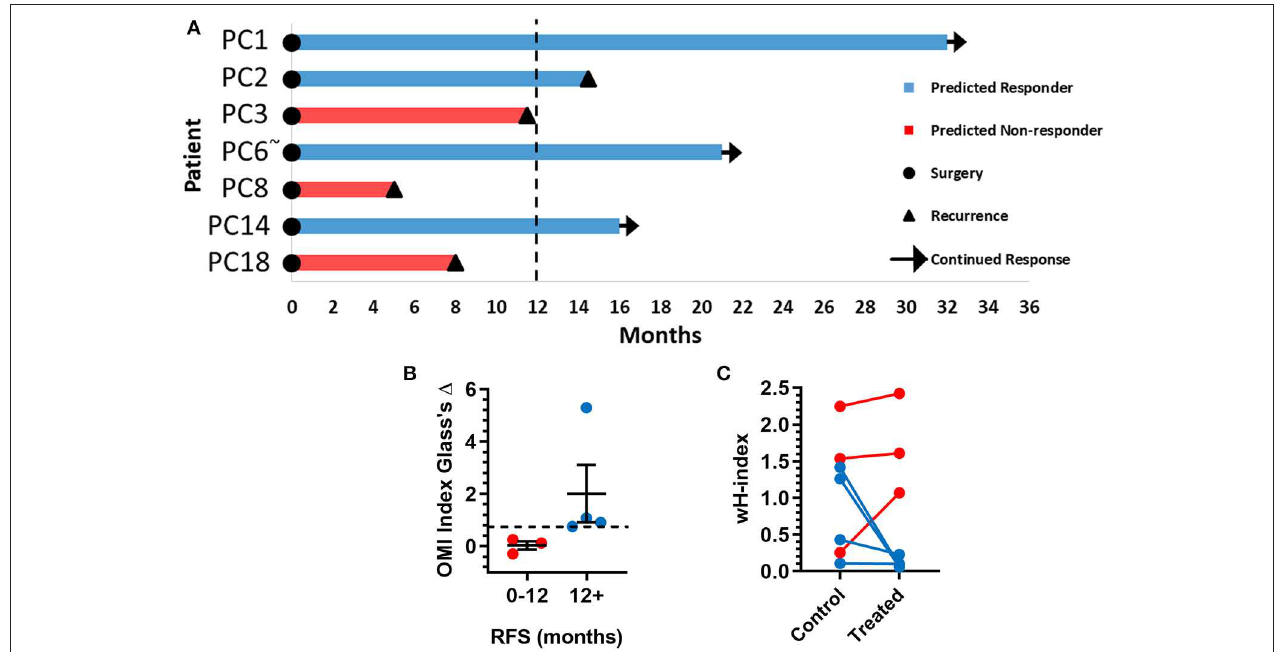
FIGURE 6 | Pancreatic cancer patient clinical outcomes while on adjuvant therapy. (A) Swimmer plot indicating the number of months without recurrence following surgical resection of the tumor and adjuvant treatment. Patients are classified as predicted responders and non-responders based on organoid response profiles. Arrows indicate that the patient continues to survive without recurrence at the time of publication. “ ∼ ” Indicates the patient’s lesion was diagnosed as ampullary cancer. (B) Patients with RFS > 12 months had higher OMI index effect sizes at 72h (Glass’s 1 ) than patients with RFS < 12 months (mean ± SEM). Dotted line represents proposed cutoff of 1 = 0.75. (C) Patients with RFS > 12 months show a decrease in wH-index with treatment compared to control organoids. Patients with RFS < 12 months show an increase in wH-index with treatment compared here to control organoids. Error bars not visible. N = 1,000